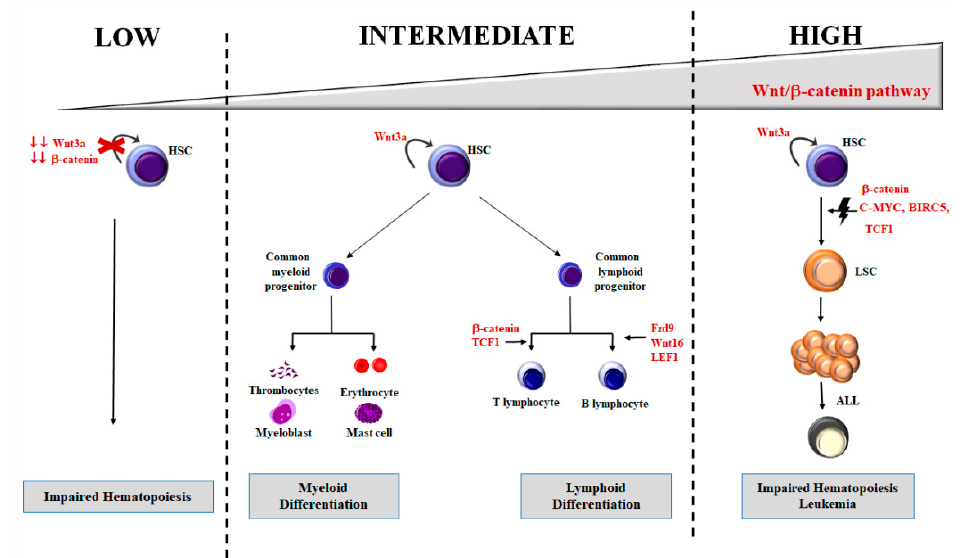
Role of Wnt / β -catenin signaling pathway in hematopoiesis and leukemogenesis. Figure 3. Role of Wnt/ β -catenin signaling pathway in hematopoiesis and leukemogenesis. Wnt/ β -catenin Wnt / β -catenin axis is di ff erentially regulated during hematopoiesis. When the pathway is inhibited, axis is differentially regulated during hematopoiesis. When the pathway is inhibited, correct hematopoiesis correct hematopoiesis is compromised whereas, when slightly activated, there is an increase of is compromised whereas, when slightly activated, there is an increase of hematological stem cell (HSC) hematological stem cell (HSC) clonogenicity and myeloid development. Intermediate-high levels clonogenicity and myeloid development. Intermediate-high levels lead to T-cell development. In addition, lead to T-cell development. In addition, very high Wnt / β -catenin activation may lead to impaired hematopoiesis and leukemia